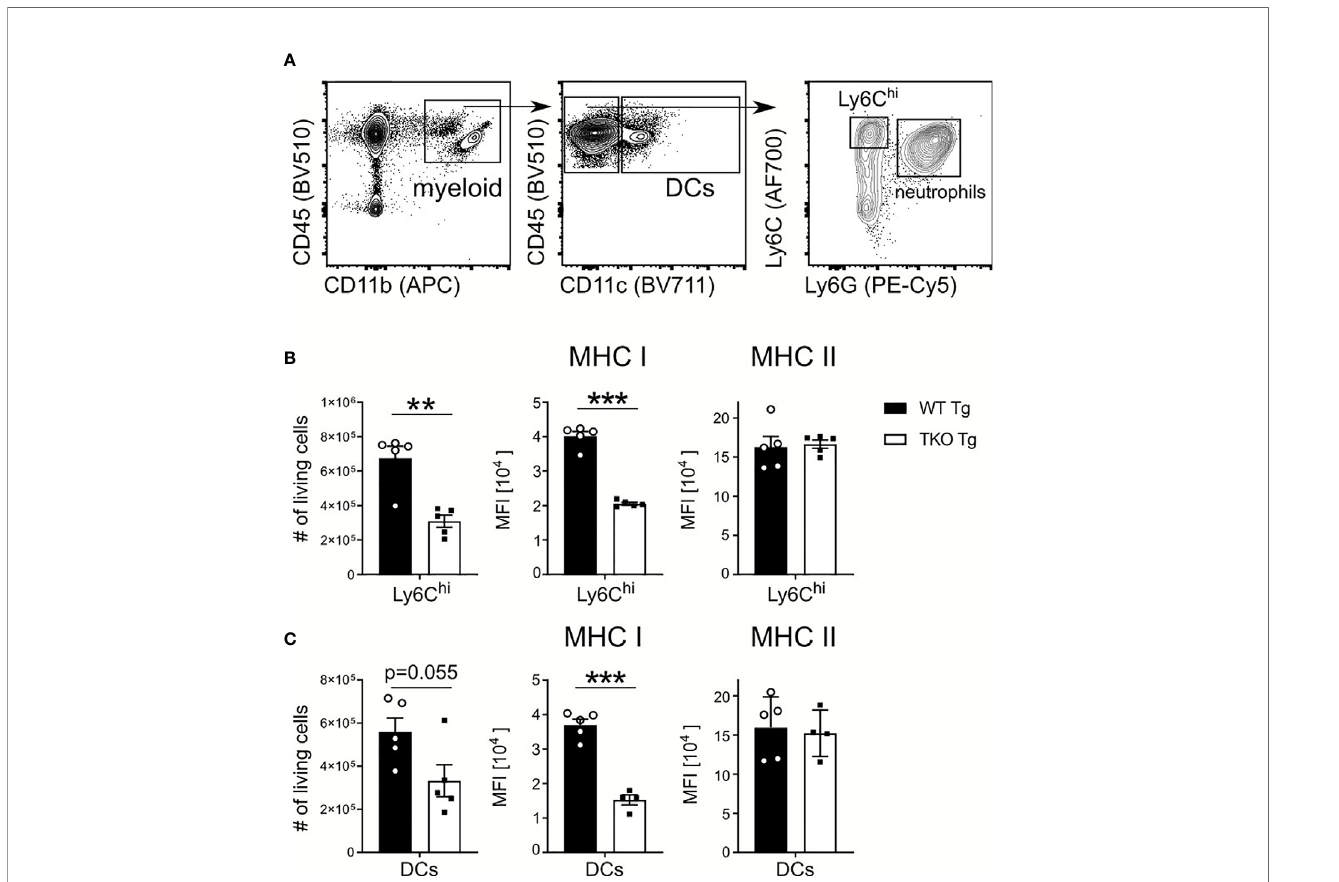
FIGURE 2 | Reduced numbers of Ly6C hi monocytes and DCs in spleen of infected TKO mice. Immune cells were isolated from the spleens of T. gondii infected WT (WT Tg, n=5) and TKO (TKO Tg, n ≥ 4) mice on day 10 p.i. and analyzed by fl ow cytometry. Following viability staining and the basic FSC/SSC gating, viable single cells were chosen for further characterization. (A) Splenocytes were fi rst gated based on surface expression of CD45, a hematopoietic marker, and CD11b, a myeloid cell marker (left plot). CD11b + CD45 + cells were further gated for CD11c and CD11c + cells identi fi ed as dendritic cells (DCs) (center plot). CD11c - cells were further divided into in fl ammatory monocytes (Ly6G - Ly6C hi ) and neutrophils (Ly6G + ) (right plot). The total number of living cells and surface expression of MHC I and MHC II were assessed for Ly6C hi monocytes (B) and DCs (C) . Expression of MHC I and MHC II was quanti fi ed using the mean fl uorescence intensity (MFI) of their respective fl uorochrome. Data shown in (A) is a representative of three independent experiments. Data shown in (B , C) represent three independent experiments; symbols represent individual animals, columns represent mean values and error bars represent ± SEM. A Mann-Whitney test was used for statistical analysis. **P < 0.01, ***P <